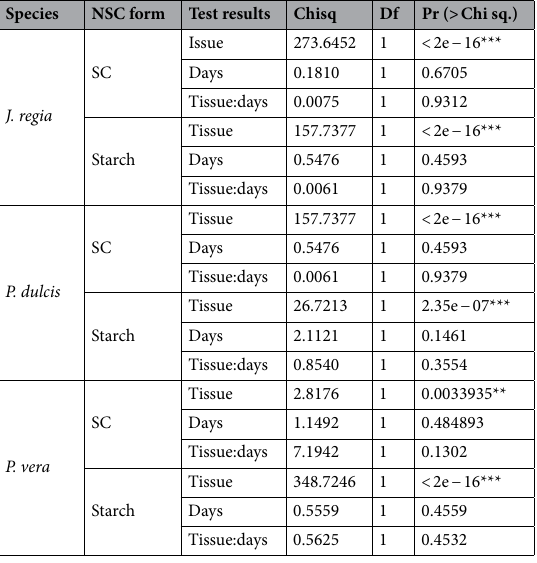
Table 2. Results of a linear mixed model analysis for the possible impact of time samples spent in a shipping envelope prior to drying. No significant impact up to 4 days was found between immediate and delayed drying in concertation of starch and soluble sugars for any of the three species. Significance codes: 0 ‘***’ 0.001 ‘**’ 0.01 ‘*’.